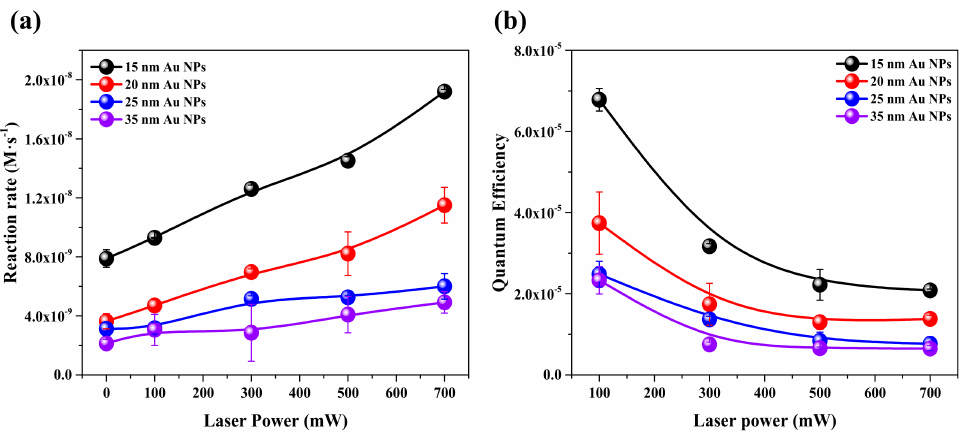
Figure 4. ( a ) Reaction rate and ( b ) quantum efficiency as a function of incident photon flux. The data points in each figure were obtained by average values obtained in at least three independent experiments under identical conditions. The error bars indicate the standard deviation taken from each identical experiment. The solid lines in the figure are visual